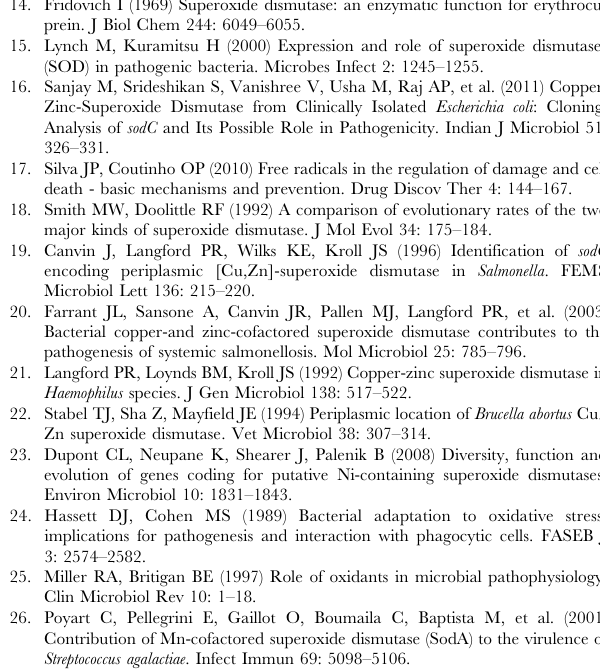
Figure S1 PCR confirmation of sod2343 inactivation. (PDF) Figure S2 Secretion of SOD2343 into the culture supernatant. (PDF) Figure S3 Secretion of SOD2343 after complementation of mutants. (PDF) Figure S4 Increased sensitivity of the sod2343 mutants to H 2 O 2 exposure. (PDF) Figure S5 Increased sensitivity of the sod2343 mutants to paraquat exposure. (PDF) Figure S6 Increased sensitivity of the sod2343 mutants to colistin. (PDF) Figure S7 Differential effects of sod2343 inactivation on sensitivity to gentamicin. (PDF) Figure S8 Increased sensitivity of the sod2343 mutants to